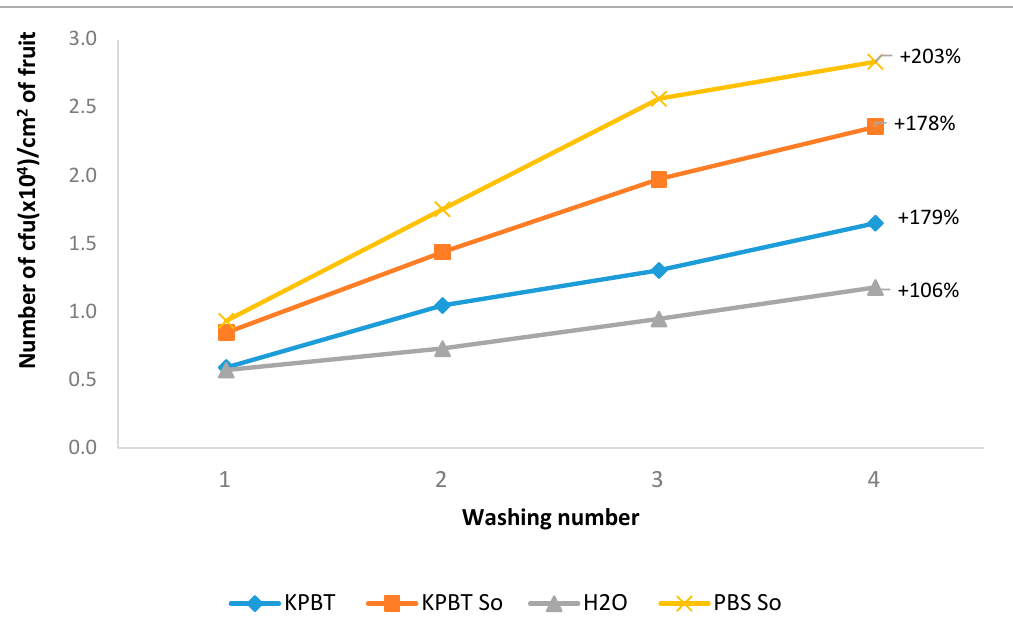
Figure 1. Mean of the cumulative number of CFU per cm 2 of apple fruit skin for bacteria and fungi counted in the four successive washes for each protocol (KPBT, KPBT So, H 2 O, and PBS So). The percentages on each graph represent the percentage increase of the sum of the four washes compared with the first.